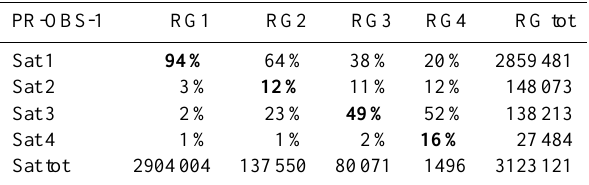
Table 12. Contingency table for the multi-categorical statistics for PR-OBS-2 as compared with rain gauge-derived rain